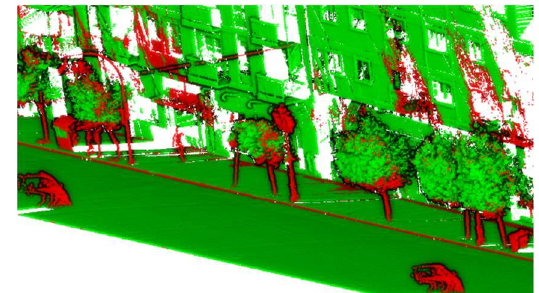
Figure 10: Point cloud coloured by correct semantic segmentation for 11 classes, 200 hidden layers and unweighted. Correct segmented classified point in green and misclassified in red.